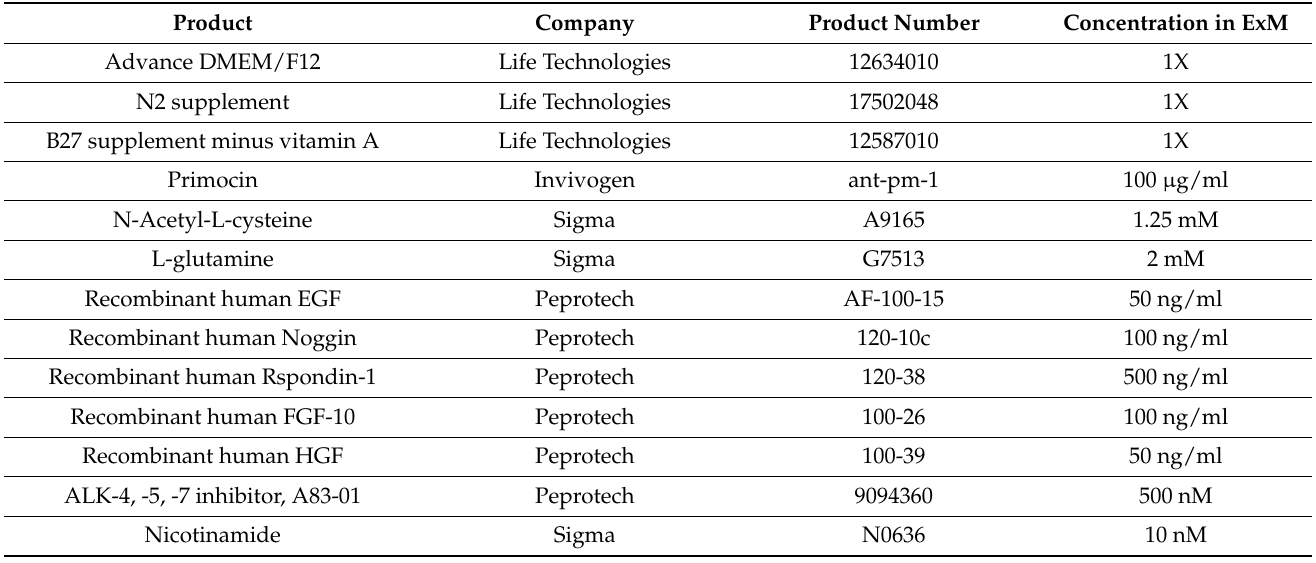
Table 1. Expansion medium (ExM)